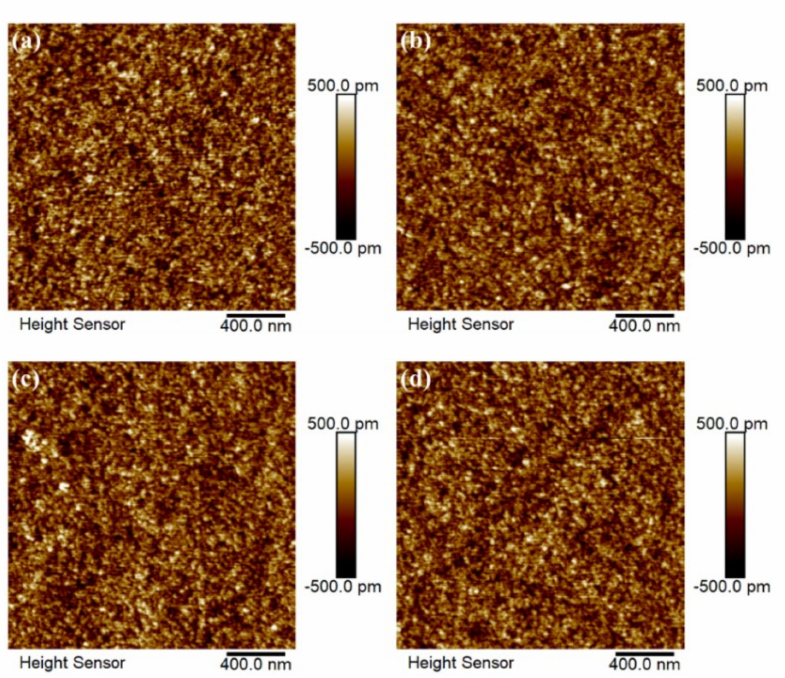
Figure 2. AFM images of the surface topography of IPO films with indicated P ratio of ( a ) 0%, ( b ) 3%, ( c ) 6%, and ( d )